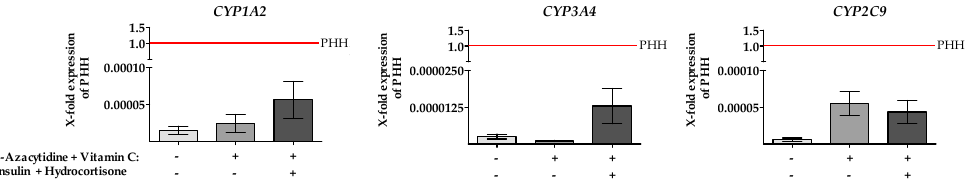
Figure 5. Incubation of HepG2 cells with 10 µ M 5-Azacytidine plus 0.5 mM Vitamin C (dark bars) and in the presence of insulin plus hydrocortisone (black bars) increased basal Cytochrome P450 (CYP) gene expression. The gene expression of CYP1A2 , 3A4 and CYP2C9 were measured by qRT-PCR after 48 h of incubation. Unstimulated controls (grey bars) as well as primary human hepatocytes (PHH) (red line) were also cultured for 48 h. The values were normalized to GAPDH. Data represent the mean of N = 3, n = 3. As positive reference served a pool of five di ff erent PHH